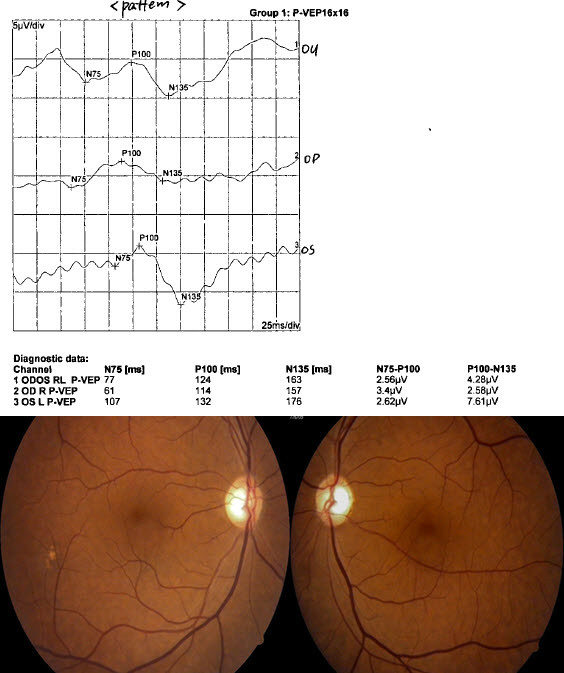
Pattern VEPs and fundi 1 year following traffic accident in a 53-year-old male. Note that the similar amplitude in both eye and delayed latency in left eye. Visual acuities were 20/100 right; 20/30 left. Optic disc was temporally slight pale in both eyes.